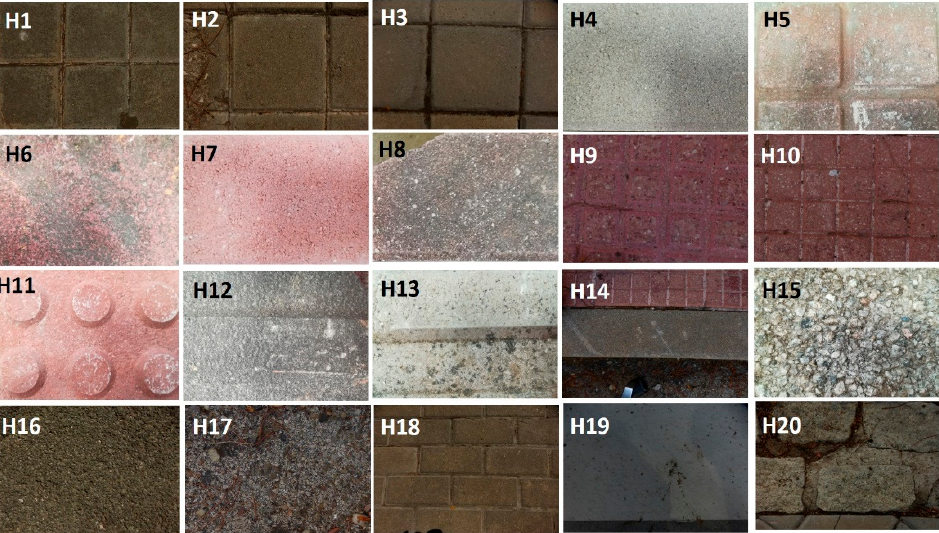
Figure 2. Horizontal surface